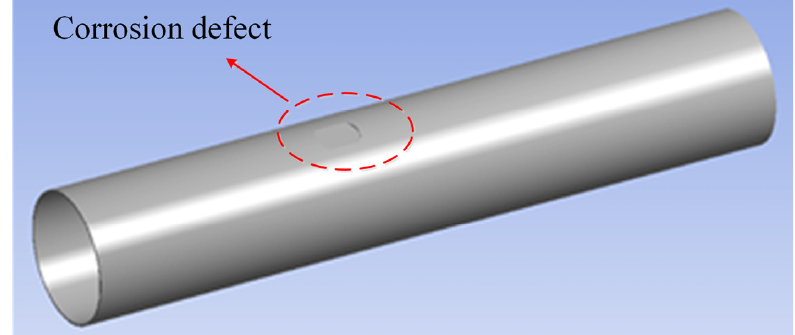
Figure 1. Geometric modeling of corroded pipeline.